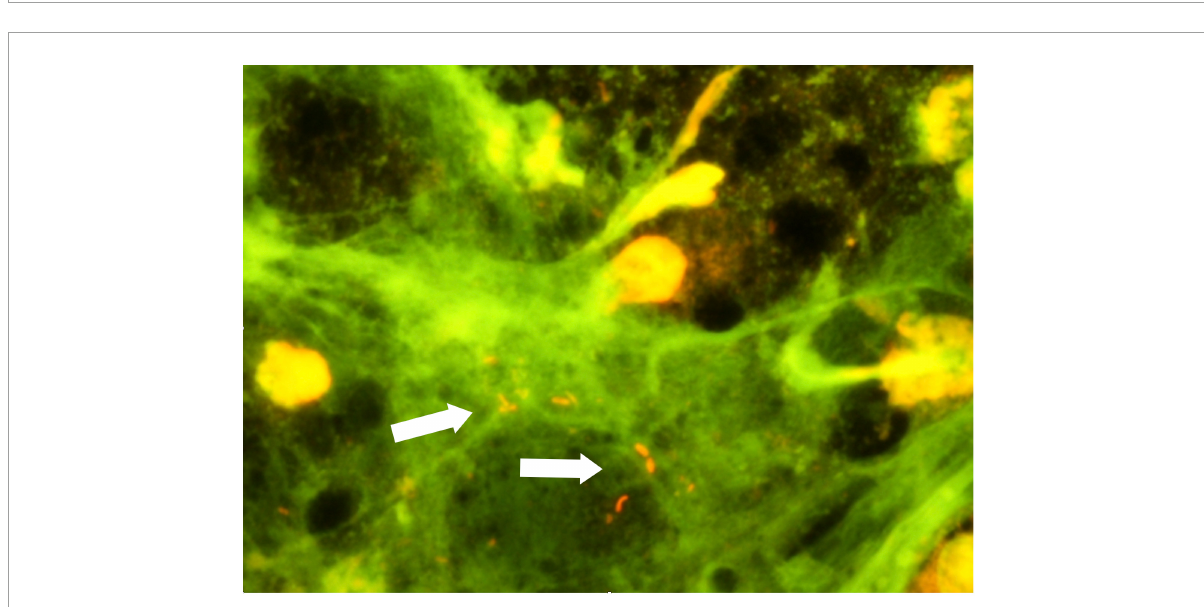
FIGURE3 Excised valve material, acridin stain. Rods marked by white